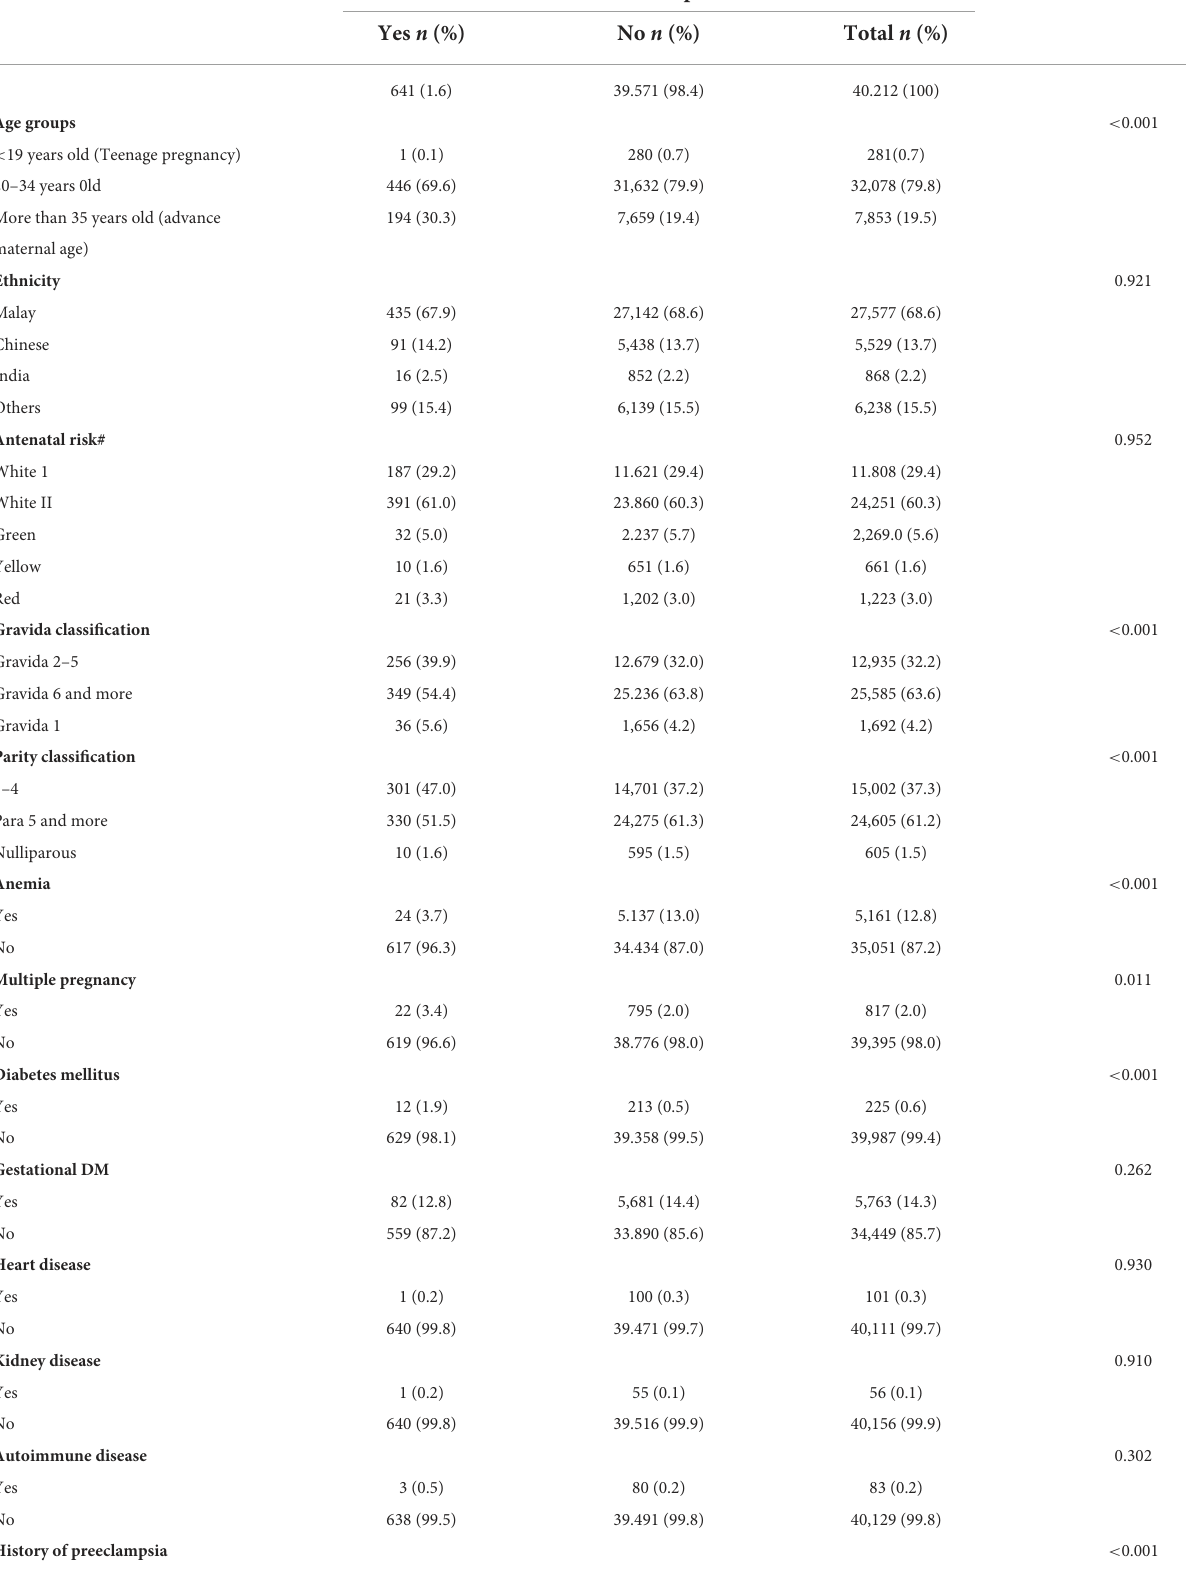
TABLE 1 Maternal sociodemographic, obstetrics and clinical